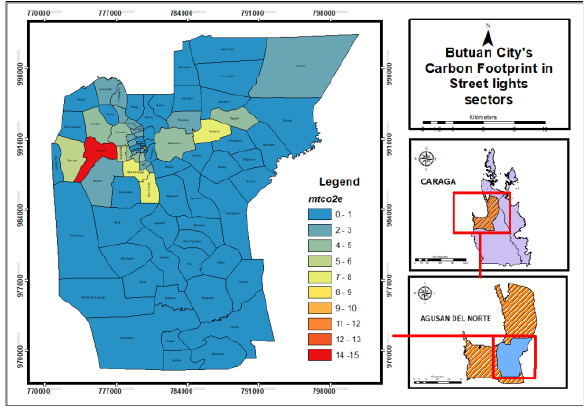
Figure 13. Spatial distribution of carbon footprint from street lights electricity consumption during COVID-19